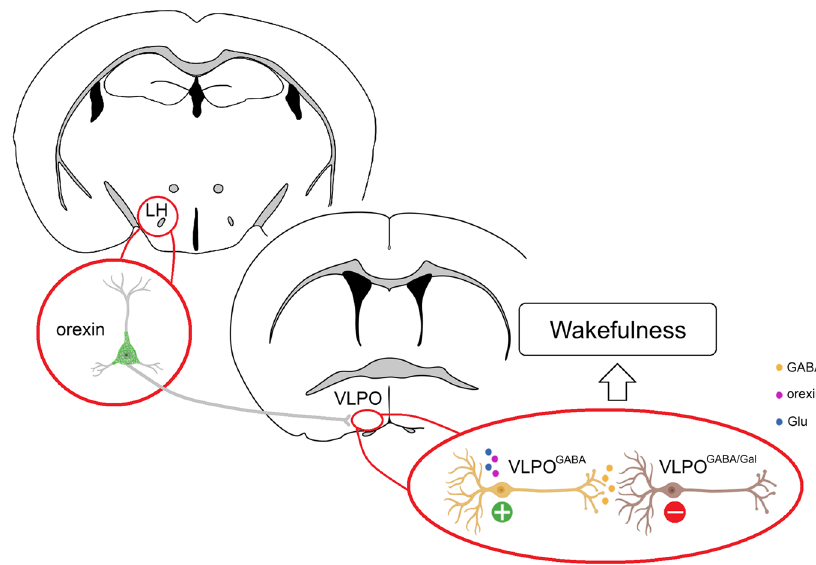
Fig. 7 Orexin neurons promote wakefulness by inhibiting sleep-promoting VLPO GABA/Gal neurons via feed-forward inhibition. Orexin neurons promote arousal through their projections to the VLPO. Orexin input to the VLPO directly activates VLPO GABAergic neurons that do not express galanin (VLPO GABA ) via co-release of Ox and glutamate. In turn, VLPO GABA neurons inhibit VLPO GABA/Gal sleep-promoting neurons to produce